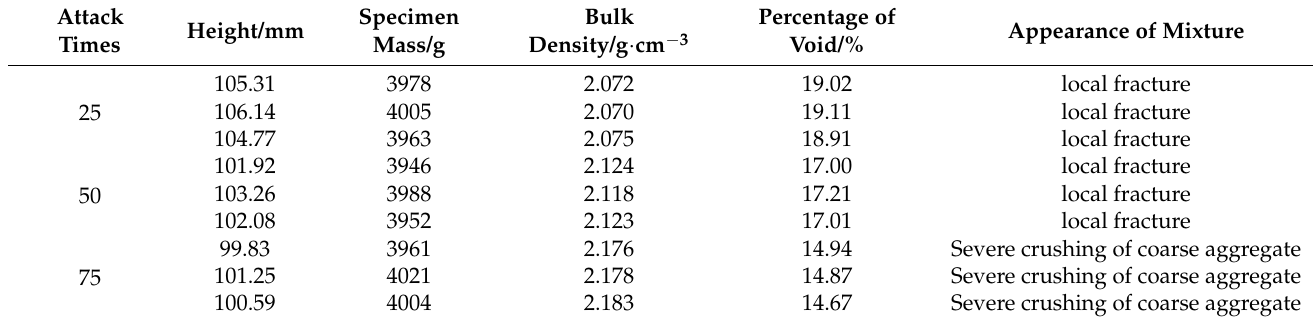
Table 4. OLSPM-25 volume parameters and mixture appearance under different compaction times.